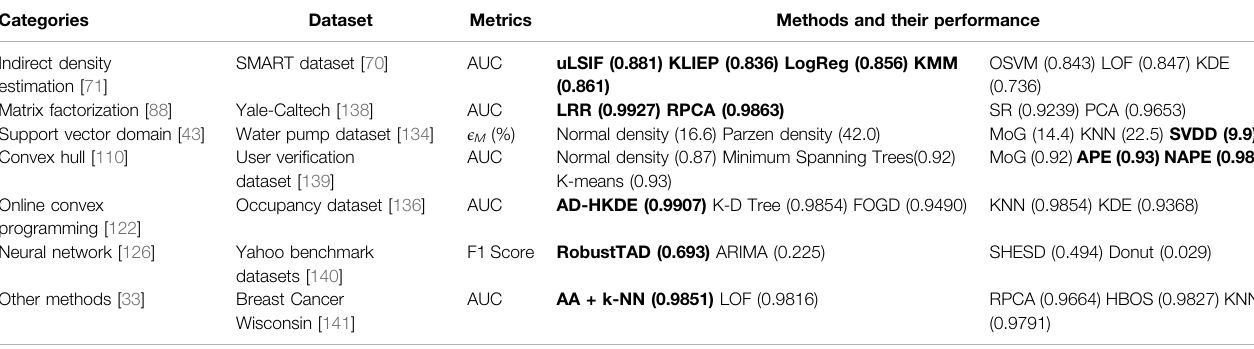
TABLE 3 | Anomaly detection performance of CA-based methods with other baseline.